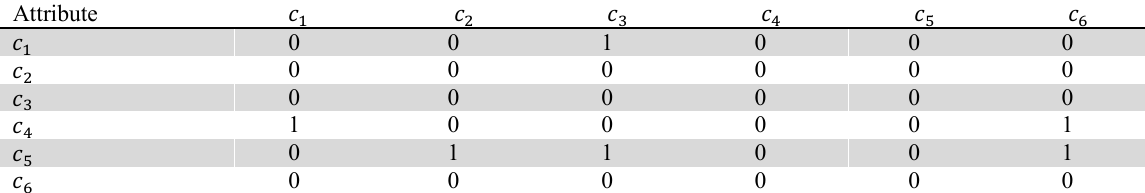
Binary relation matrix for supplier evaluation problem